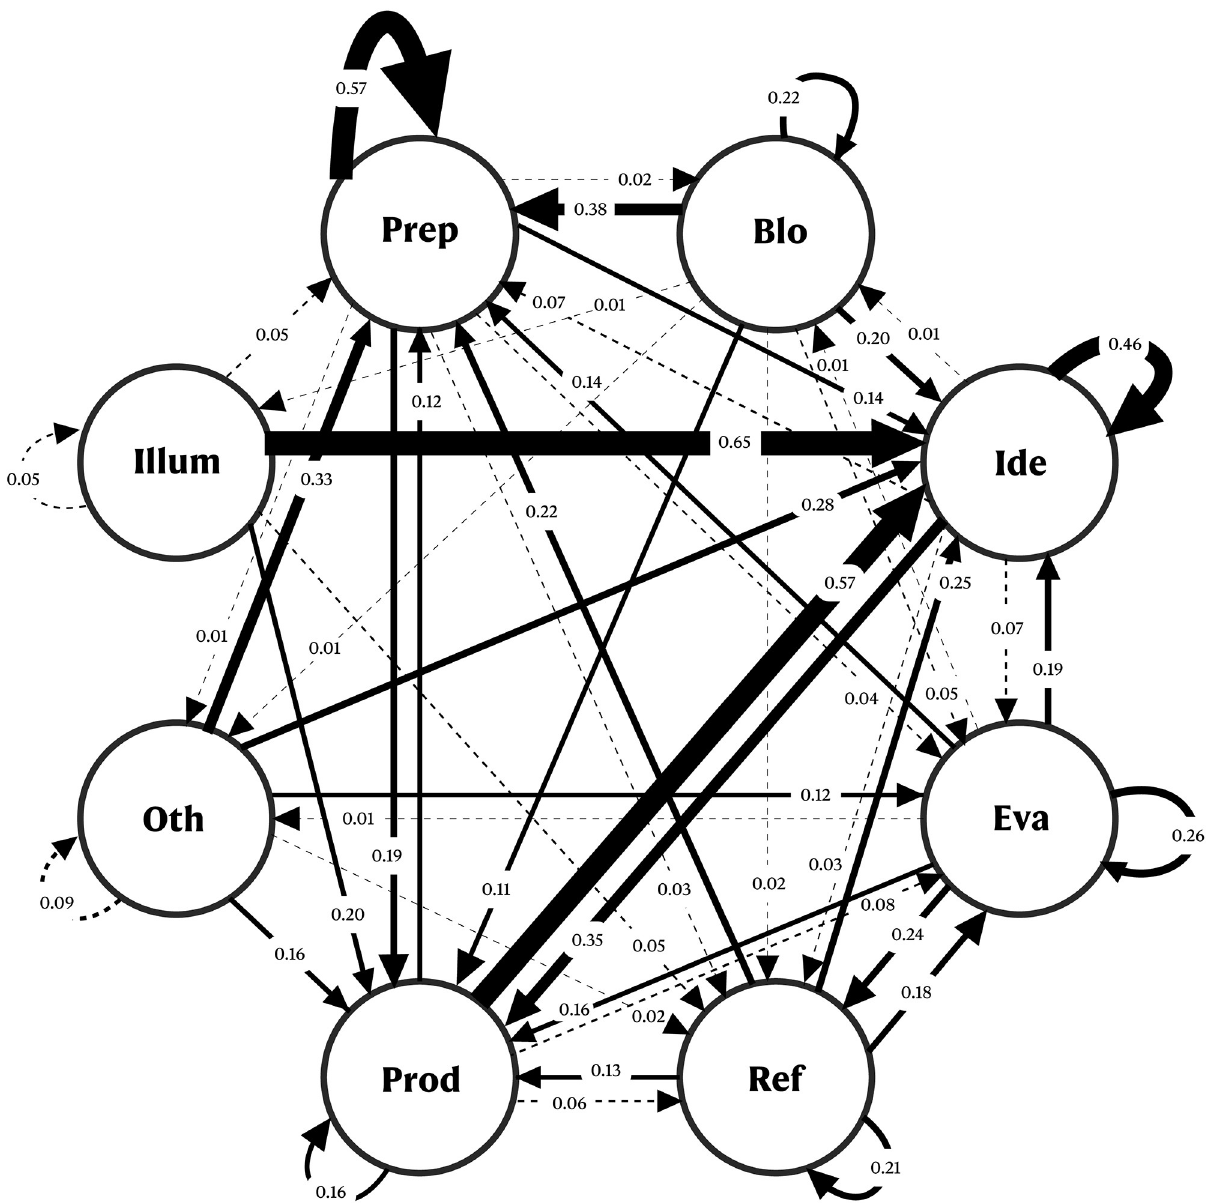
Fig 6. Diagram of transitional states for the various stages of the SPS group. Blo = Block; Ide = Ideation; Eva = Evaluation; Ref = Refinement; Prod = Production; Oth = Others; Illum = Illumination.